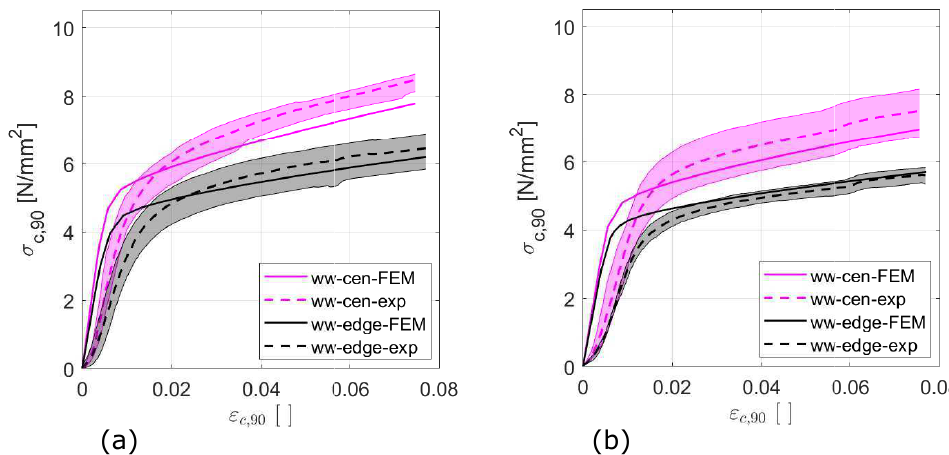
Figure 8. Wall thickness effect: Compression stress vs. strain curves for center positions of walls in series ( a ) W80-F140 and ( b ) W100-F140